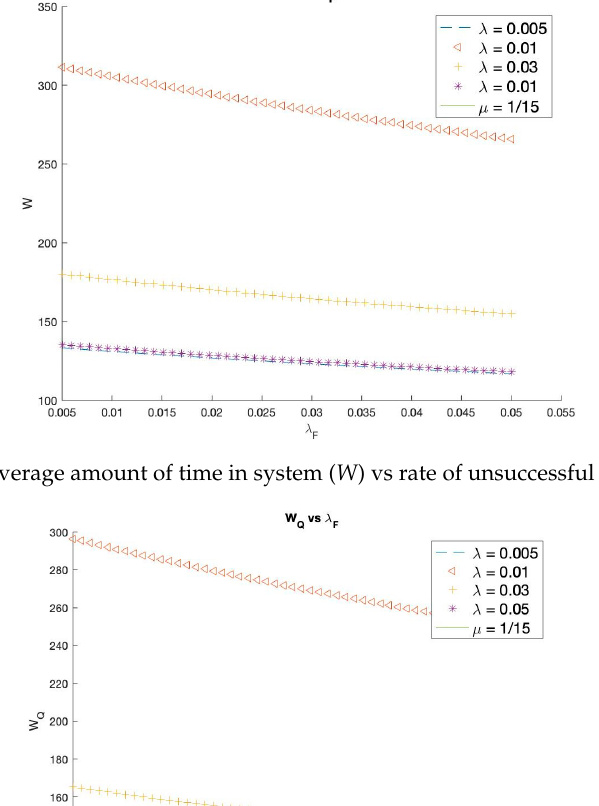
Figure 14. Average amount of time in queue ( (cid:1849) (cid:3018) ) vs rate of unsuccessful arrival ( λ (cid:3007) ).